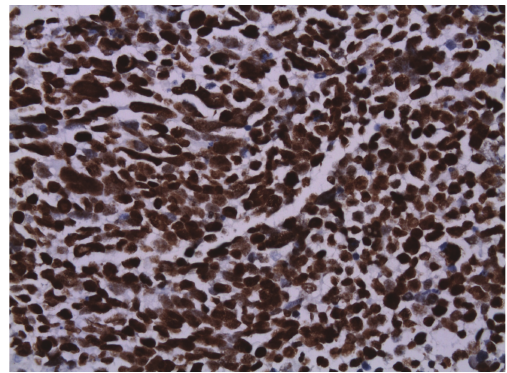
Figure 6: The tumor cells are strongly di ff use positive for chro- mogranin A (Immunohistochemical stain, original magnification, × 400).